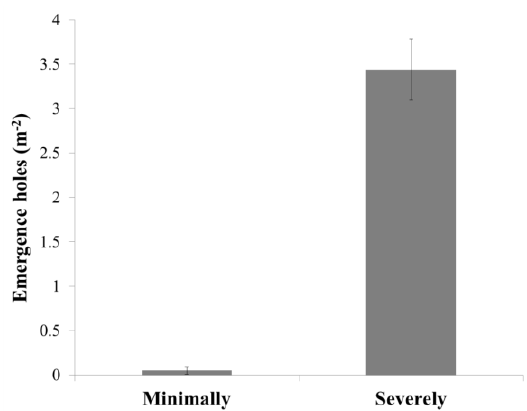
Figure 4. Mean density of Phoracantha semipunctata emergence holes (m −2 ) per bottom 2 m of stems in minimally and severely drought-affected forest areas in Northern Jarrah Forest, southwestern Australia. Significant differences between forest areas were found for emergence holes from Kruskal–Wallis tests at alpha = 0.05. Error bars represent the standard error of the mean, n =